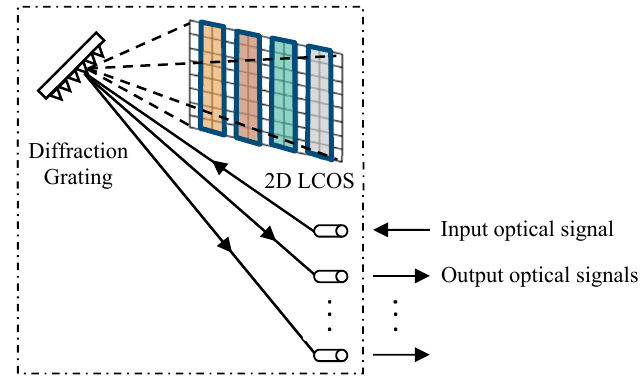
Figure 1. The schematic of an liquid crystal on silicon (LCOS) based optical processor.